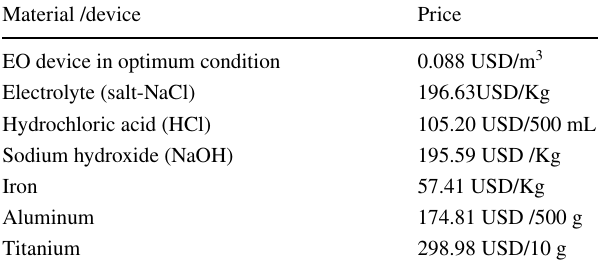
Table 11 Economic evaluation of EO process